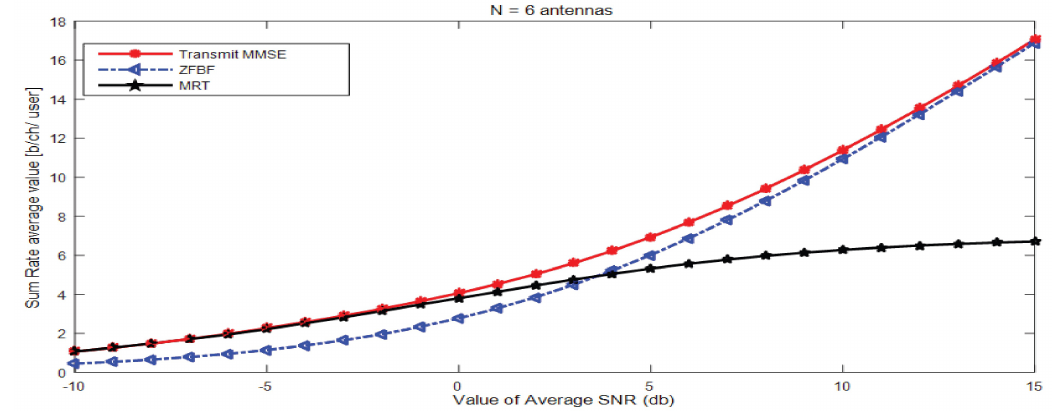
Figure 1. Performance of Transmit MMSE, MRT and ZFBF is low for less antennas N ( N = 4) and user function SNR, (signal to noise ratio received at the user end) shows that high SNR limit the interuser interface and transmit MMSE performs best.